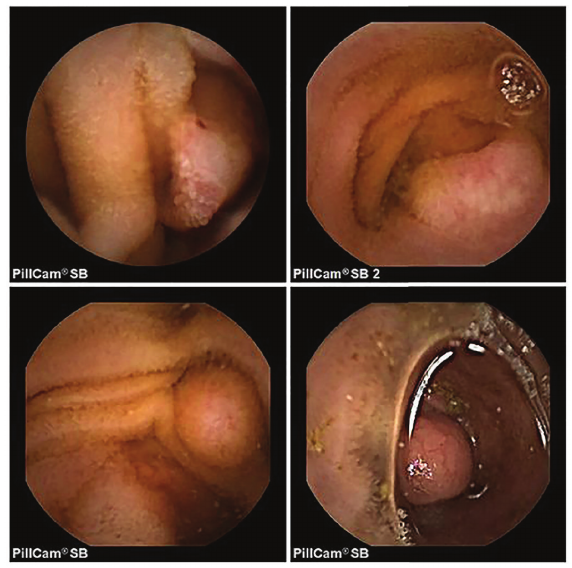
Figure 1: Several WCE images with tumor.